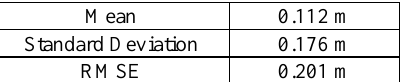
Table 1. Altimetry errors computed from 9 GCP.